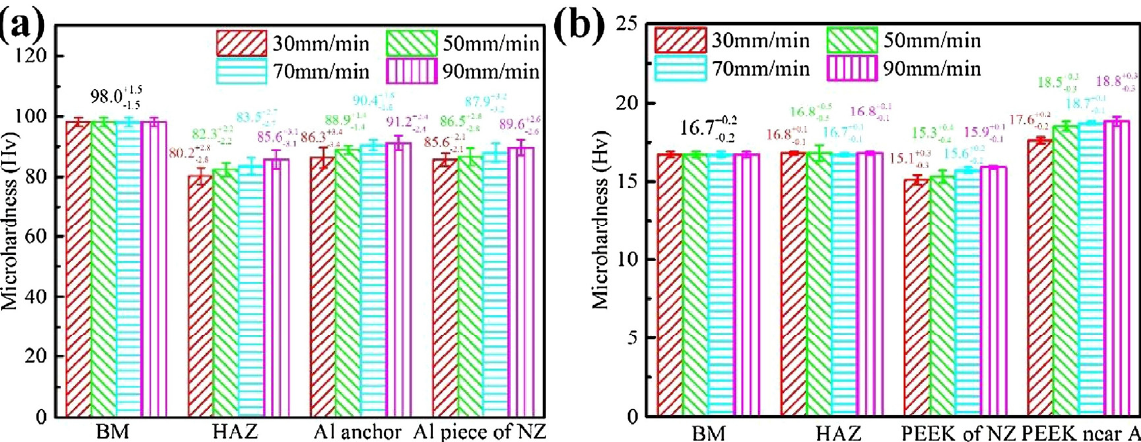
Figure 11. Rotational velocity effect on weld zones hardness at the ( a ) metal and ( b ) polymer. Reprinted with permission from Ref. [85]. 2016, Shahmiri et al.